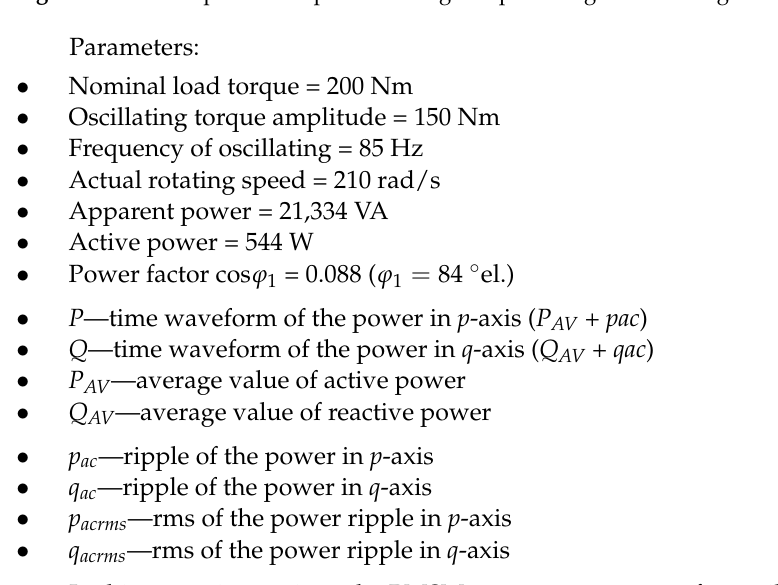
Figure 16. AC components of power during compensating of oscillating ICE engine torque.